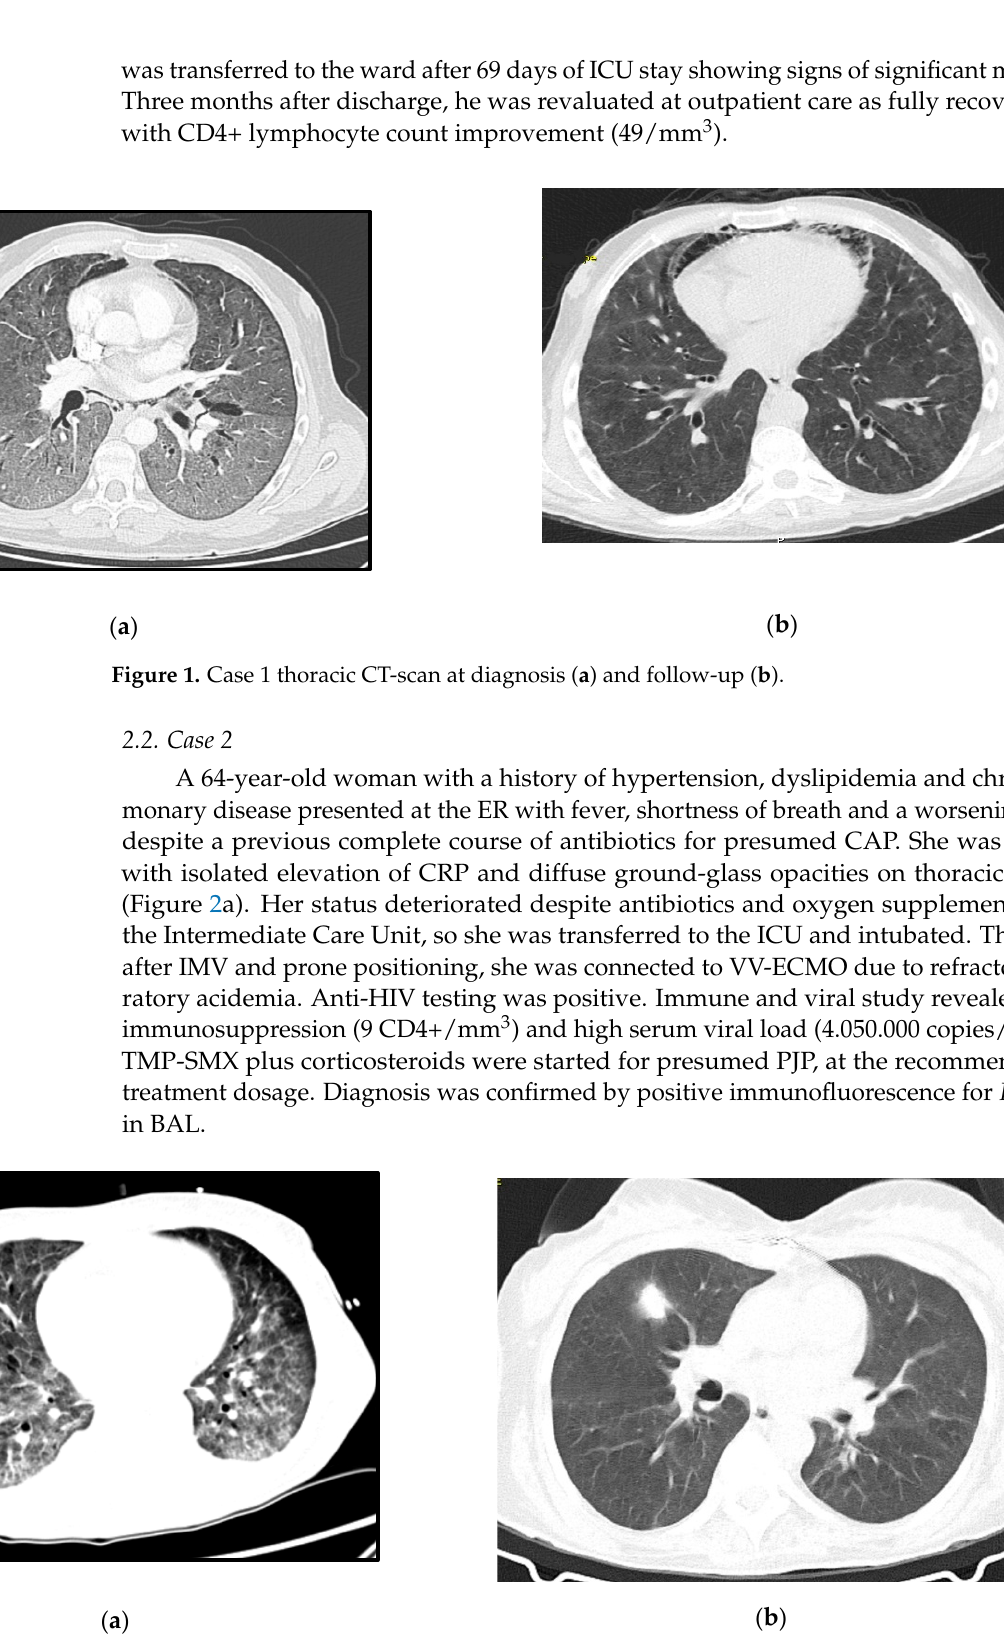
Figure 2. Case 2 thoracic CT-scan at diagnosis ( a ) and follow-up ( b ). 2.3. Case